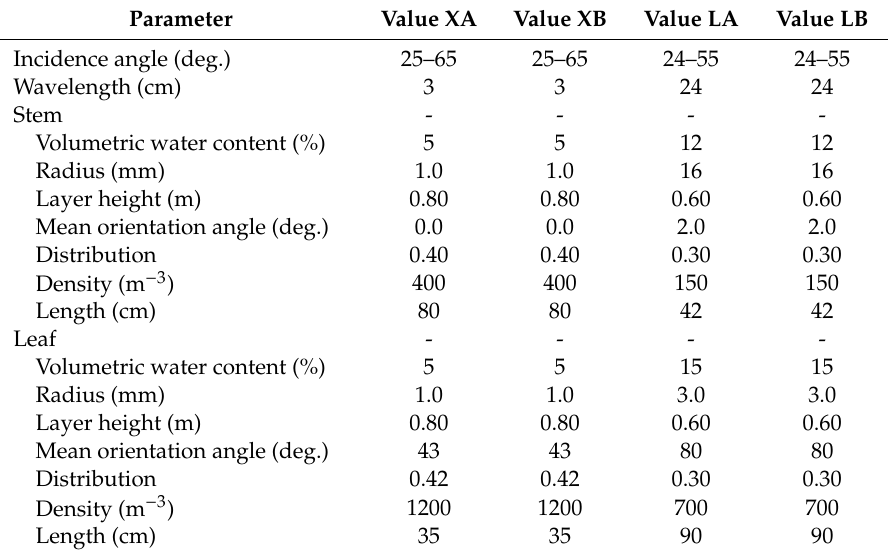
Table 1. Model input parameters [36].